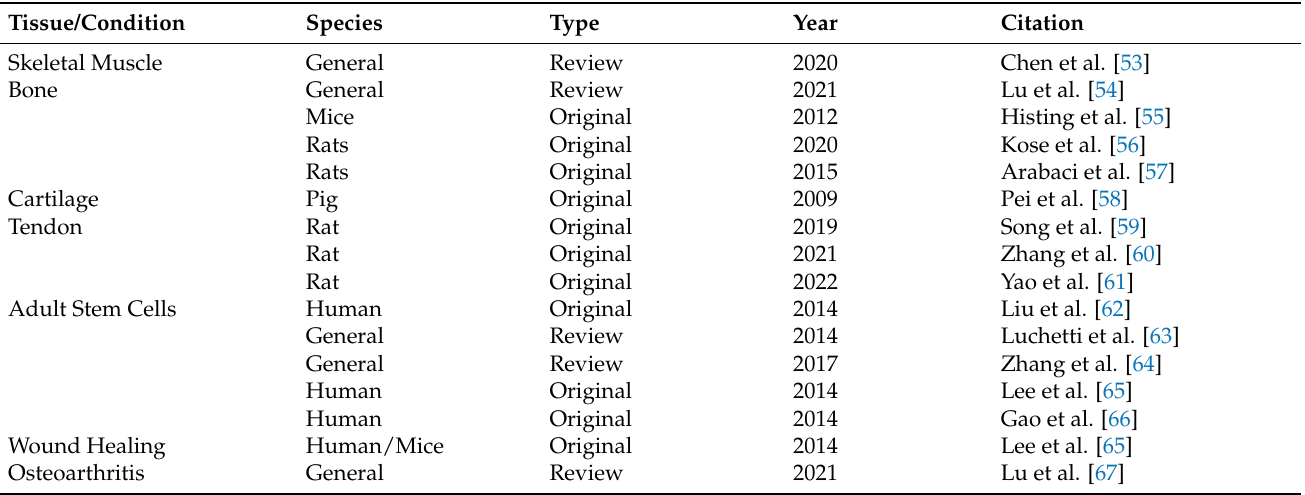
Table 1. Influence of melatonin on MSK tissues, cells, and